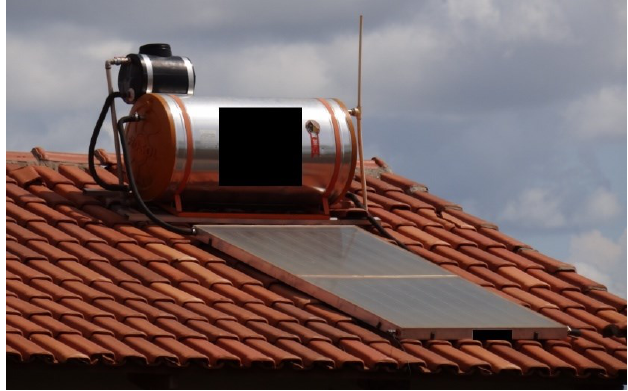
Fig. 1. Solar water heating system in home of low-income